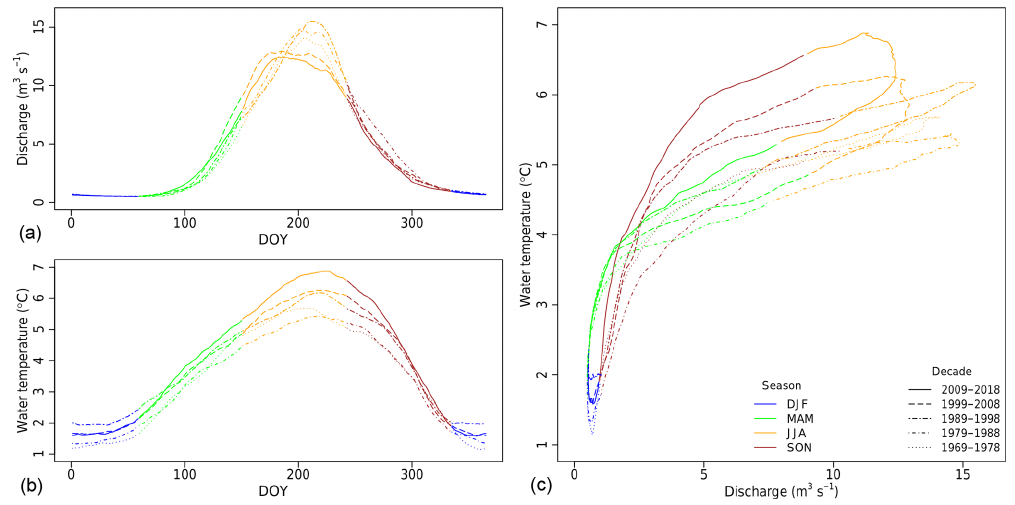
Figure 12. Hydrological (a) and thermal (b) regimes per decade for the Lonza River in Blatten averaged for each day of the year (DOY). Line types represent decades and colours denote the seasons. (c) Decadal temperature plotted against decadal discharge (both averaged for each day of the